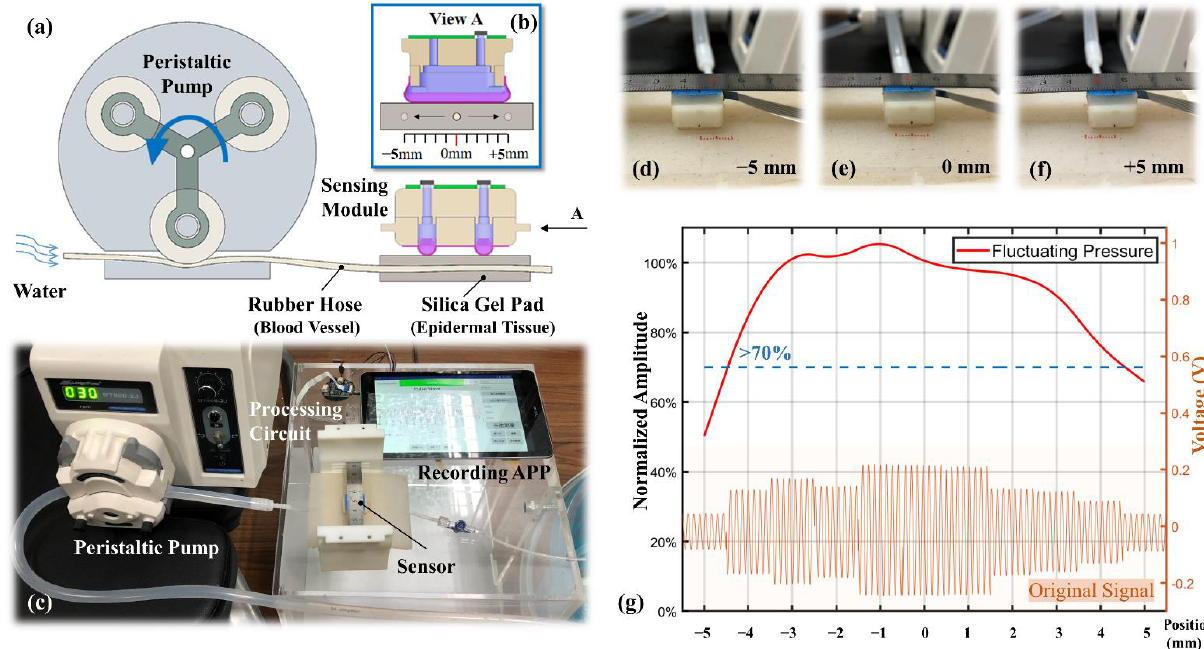
Figure 7. Experimental setup for location robustness: ( a ) schematic diagram of the experimental platform; ( b ) right elevation of the sensing module; ( c ) photo of the experimental setup; ( d – f ) different test locations; ( g ) results of the location robustness experiment.